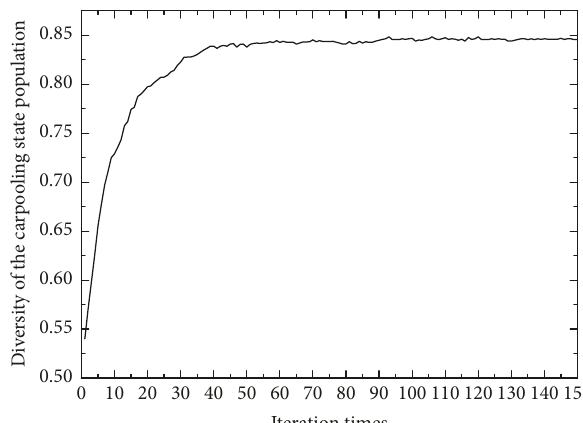
Figure 3: The diversity evolution of the carpooling states popula-